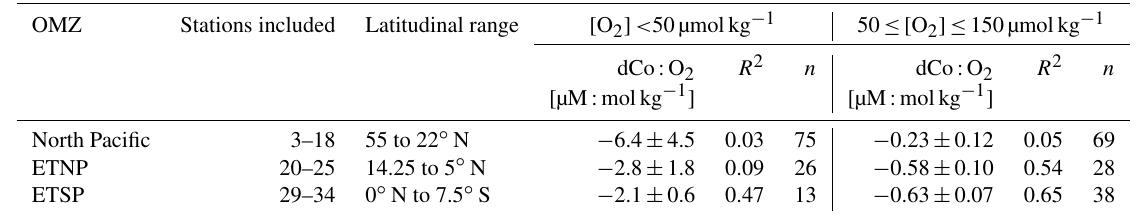
Table A1. Two-way regression statistics for the dCo vs. O 2 relationship in the three Pacific OMZs, separated by O 2 concentration (shown in Fig. A1c, g, k). In the North Pacific OMZ, samples at and below 500m depth were included in the regression, and in the ETNP and ETSP, samples at and below 150m depth were included. Note that R 2 values of the regressions were particularly low within the North Pacific and low-[O 2 ]